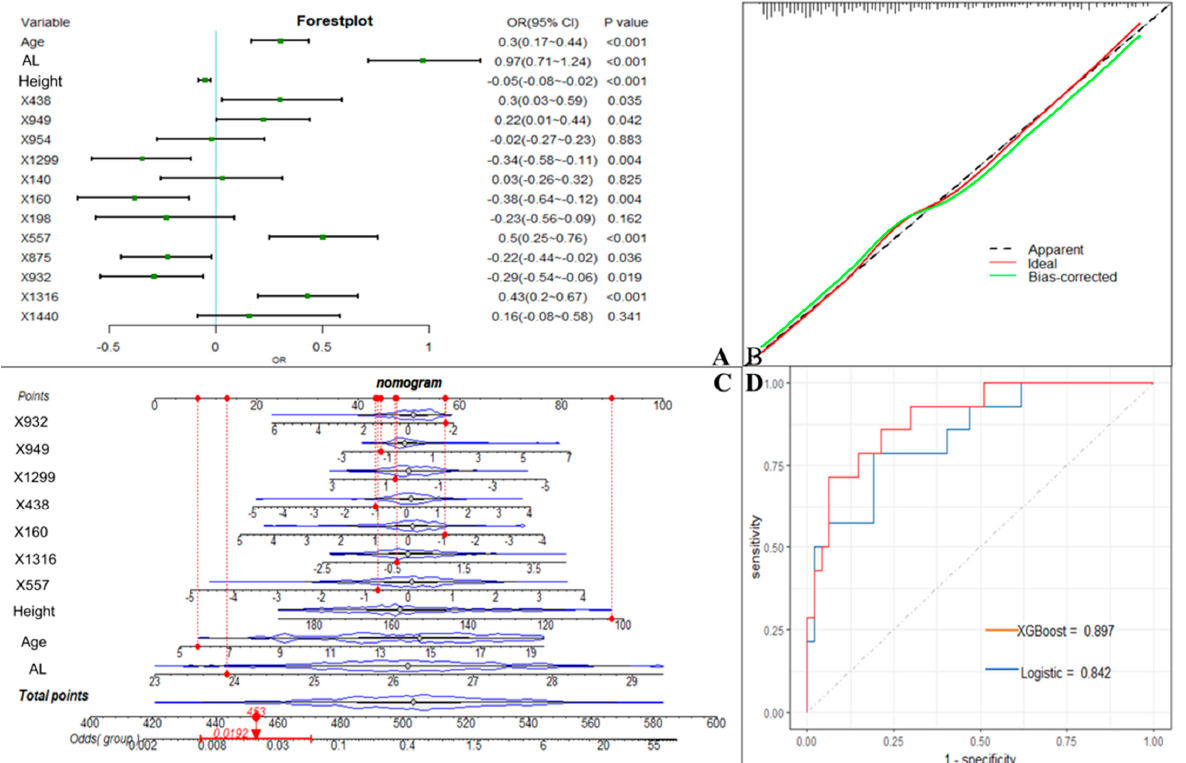
Figure 4. Machine learning model incorporating metabolic features. ( A ). OR values of predictor variables and their 95% confidence intervals in the logistic model incorporating metabolic features. ( B ). Calibration curves of logistic model column line graphs in the validation cohort. ( C ). Estimation of the probability of macular lesions by creating column line plots in the training set. ( D ). Area under the receiver operating characteristic curve for predicting the sensitivity and specificity of the model in the validation set, as determined by 2 machine learning algorithms: support vector machine and logistic regression. * X438 (proline), X949 (citric acid), X954 (hypoxanthine), X1299 (stearic acid), X140 (2-hydroxybutanoic acid), X160 (2-hydroxy-2-methylbutanoic acid), X198 (3-hydroxybutyric acid), X557 (resorcinol), X875 (ribitol), X932 (phosphoethanolamine), X1316 (isolinoleic acid), X1440 (docosenoic acid).